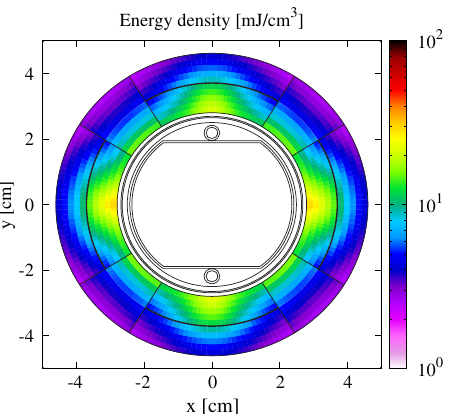
FIG. 8. Simulated transverse energy density distribution for the short-duration collimation quench test in the Q6.L8 coils (2500 A) at the position where the maximum energy deposition